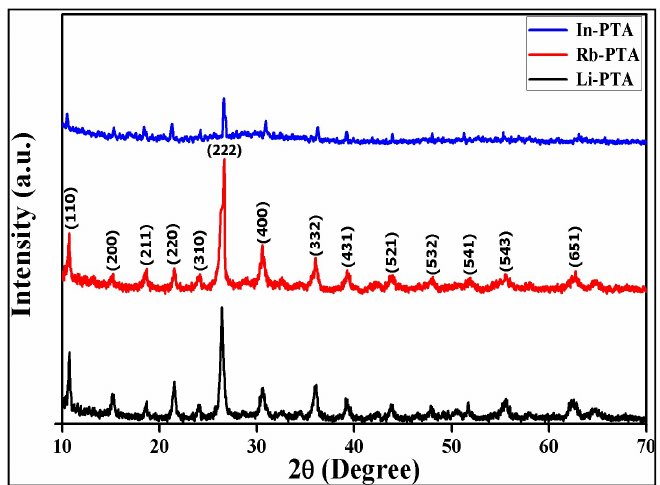
Figure 3. XRD patterns of Li−PTA, Rb−PTA, and In−PTA thin films. The lattice parameters for the spinel cubic structure (a=b=c) for Li + , Rb + , and